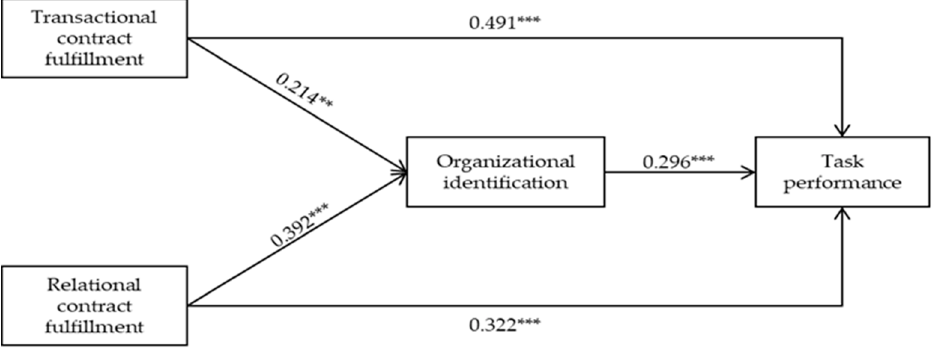
ffi cient of the hypothesis model. ** p < 0.01; *** p < Figure 2. Path coefficient of the hypothesis model. ** p < 0.01; *** p < 0.001. Figure 2. Path coe